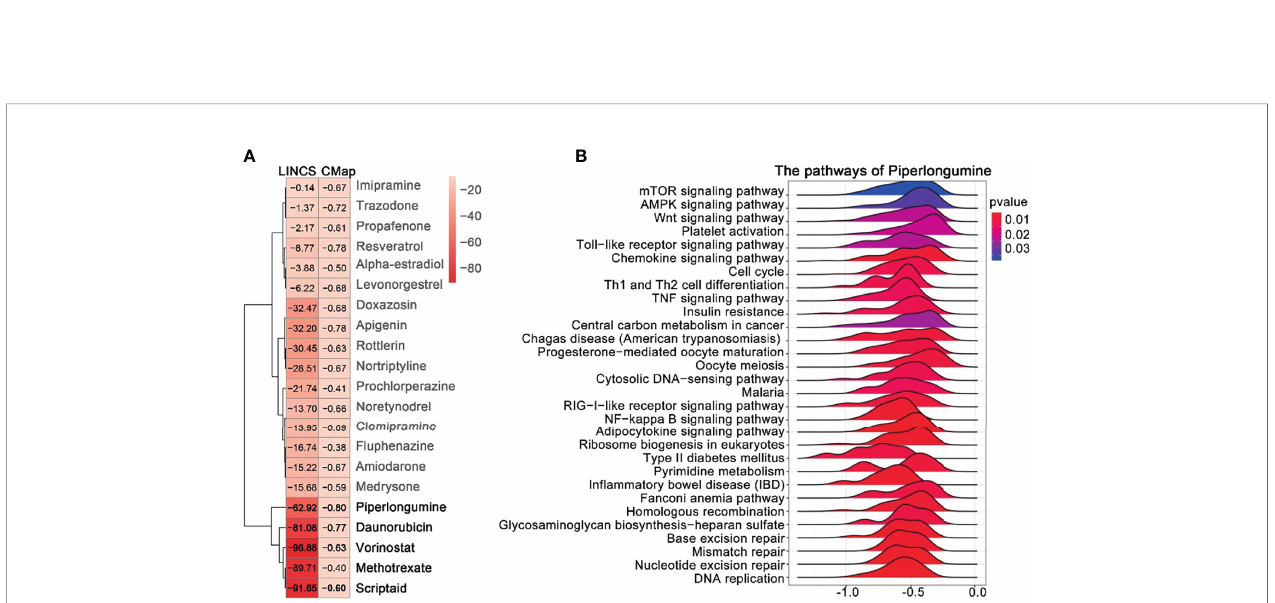
FIGURE 4 | Prediction of drug candidates and drug GSEA analysis. (A) Similarity score table for the drugs having at least one signi fi cant association with connectivity map databases. Each row corresponds to a drug, and columns correspond to two-generation connectivity map databases. The score labels with numbers indicate the signi fi cance of the results. The row labels written in bold indicate the drugs we selected for further analysis. (B) GSEA analysis of the piperlongumine was assessed by the clusterPro fi ler package; p-value < 0.05 was considered statistically signi fi